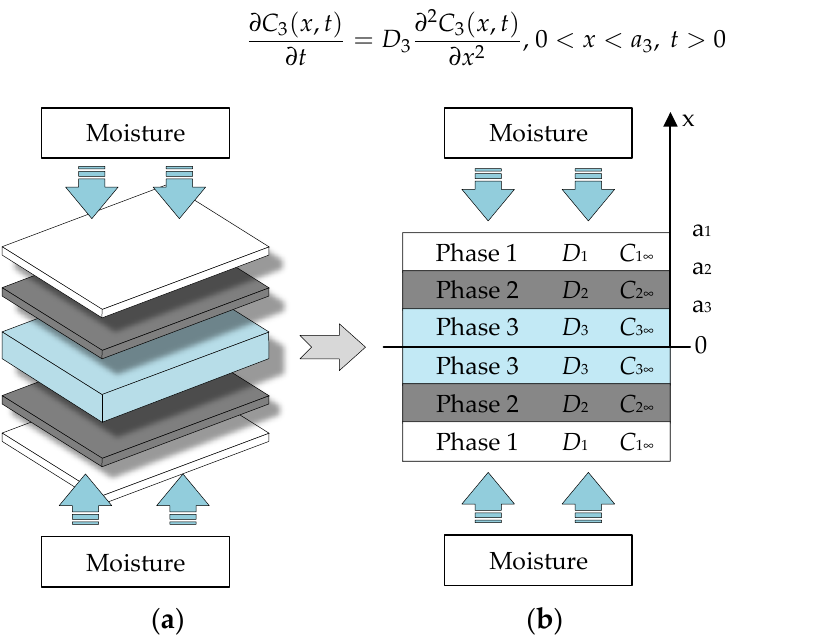
Figure 1. The moisture diffusion problem of multiphase symmetrical sandwich structure: ( a ) Description of multiphase symmetrical sandwich structure; ( b ) Model of moisture diffusion problem.